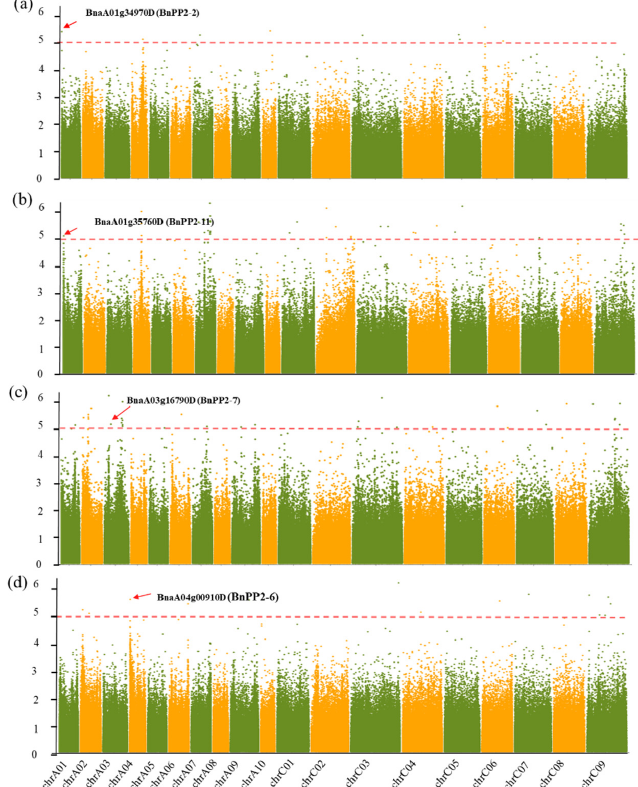
Figure 6. The genome-wide association analysis (GWAS) for SD resistance in a B. napus population comprising 324 accessions and Manhattan plots of SD resistance from association analyses: ( a ) Manhattan plots of the disease after 48–24 h; ( b ) Manhattan plots of the disease after 36–24 h; ( c ) Manhattan plots of the disease after 48 h; ( d ) Manhattan plots of the disease after 24 h. The red dashed line shows the GWAS threshold (1/SNP number).